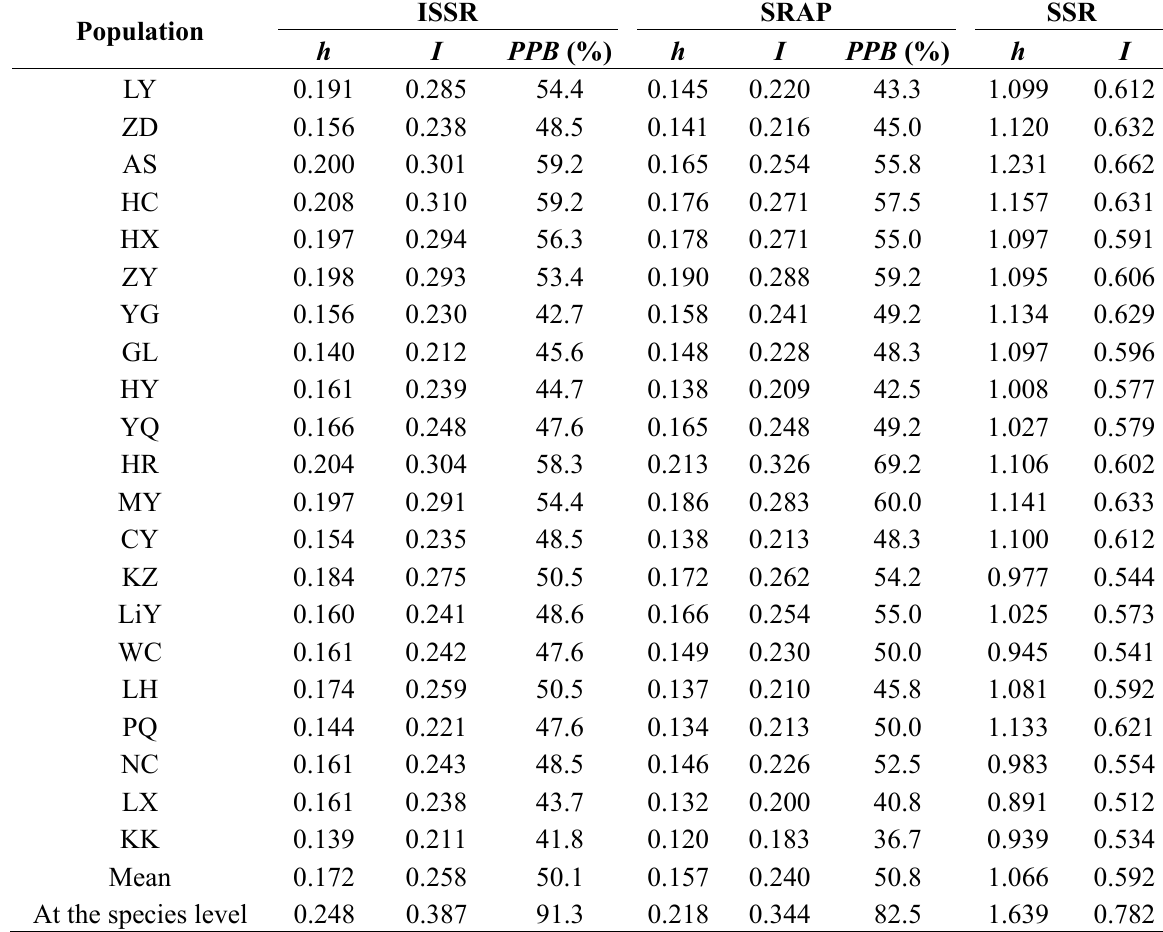
Table 1. Genetic diversity parameters of the Siberian apricot populations analyzed.